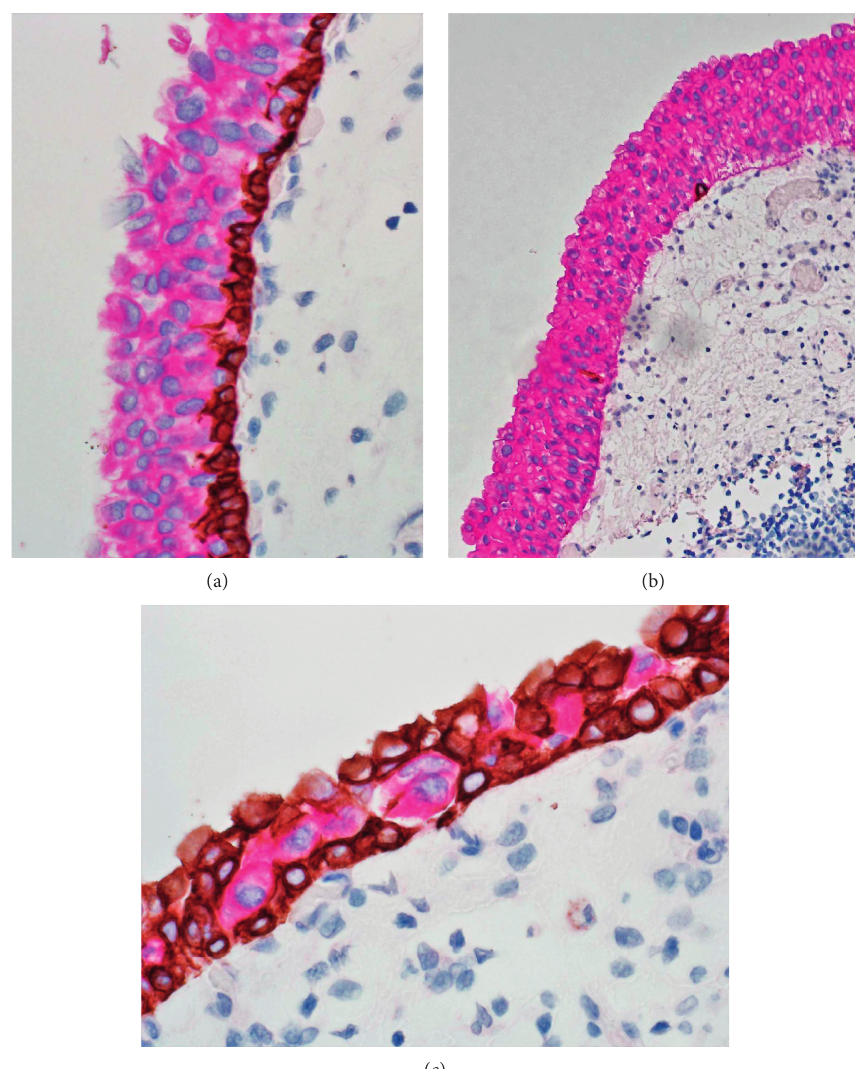
Figure 7: (a) Urothelial carcinoma in situ with strong full-thickness immunostaining for CK20 with a distinct basal cell layer positive for CK5/ 6. (b) Another urothelial carcinoma in situ featuring strong staining for CK20 and absence of basal layer. (c) Pagetoid extension of urothelial carcinoma demonstrated by strong cytoplasmic staining for CK20 in a background of multiple layers of basal cells reactive for